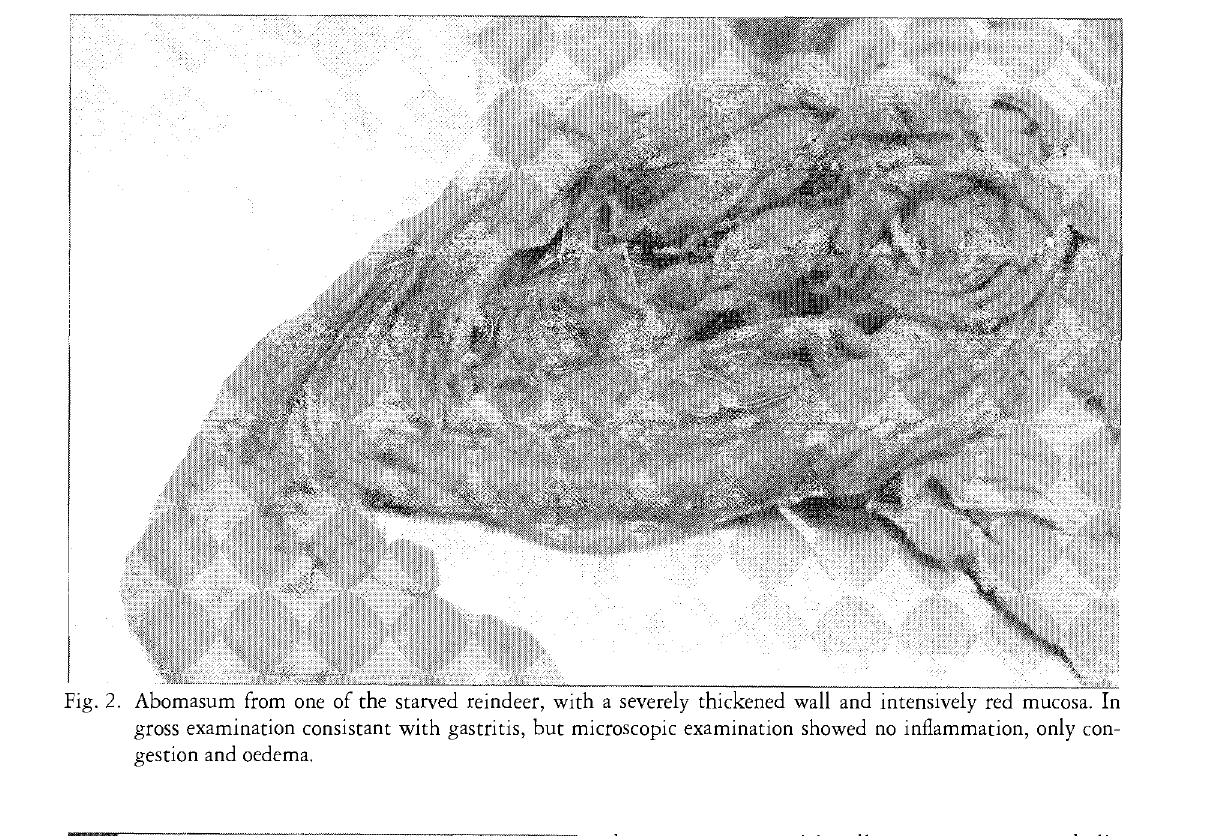
Fig. 2. Abomasum from one of the starved reindeer, with a severely thickened wall and intensively red mucosa. In gross examination consistant with gastritis, but microscopic examination showed no inflammation, only con gestion and oedema.